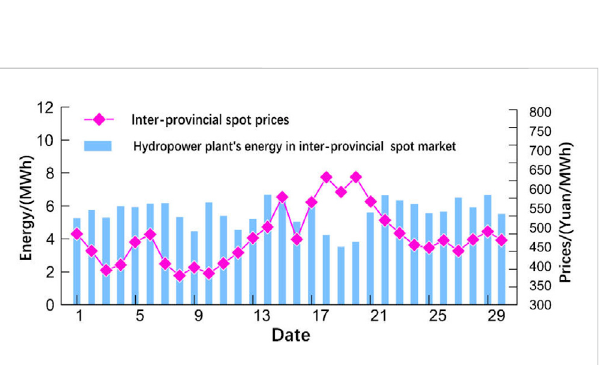
FIGURE 5 Matching analysis of hydropower plant ’ s energy in inter- provincial spot market and the spot